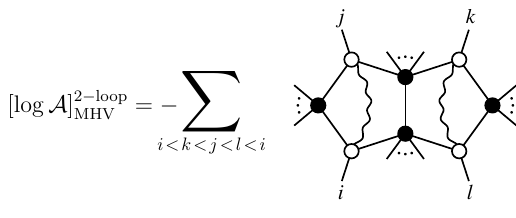
Figure 3 . Two-loop logarithm of the MHV amplitude. Figure from ref. [73].